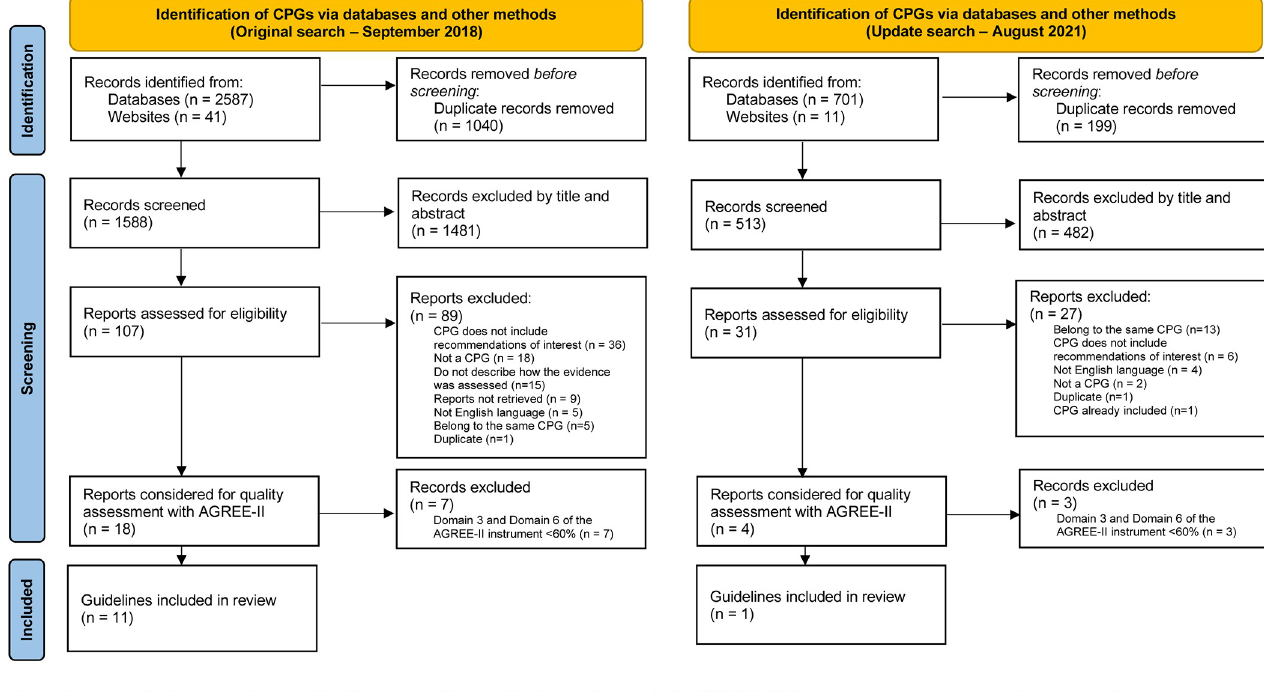
Fig 1. PRISMA flow